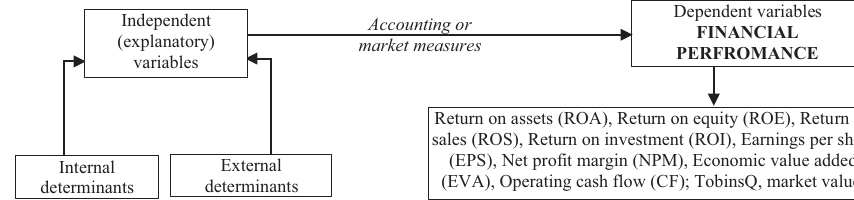
Figure 1. The causal model between financial performance and its determinants (source: elaborated by the